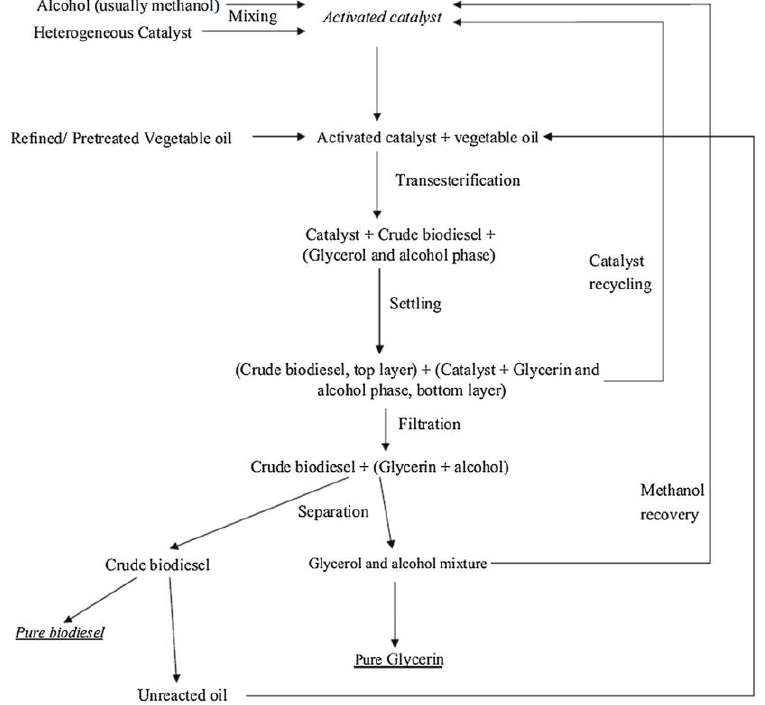
Figure 6. Flowchart of biodiesel synthesis using heterogeneous catalyst. Reprinted with permission from Ref. [12]. 2022, Elsevier.